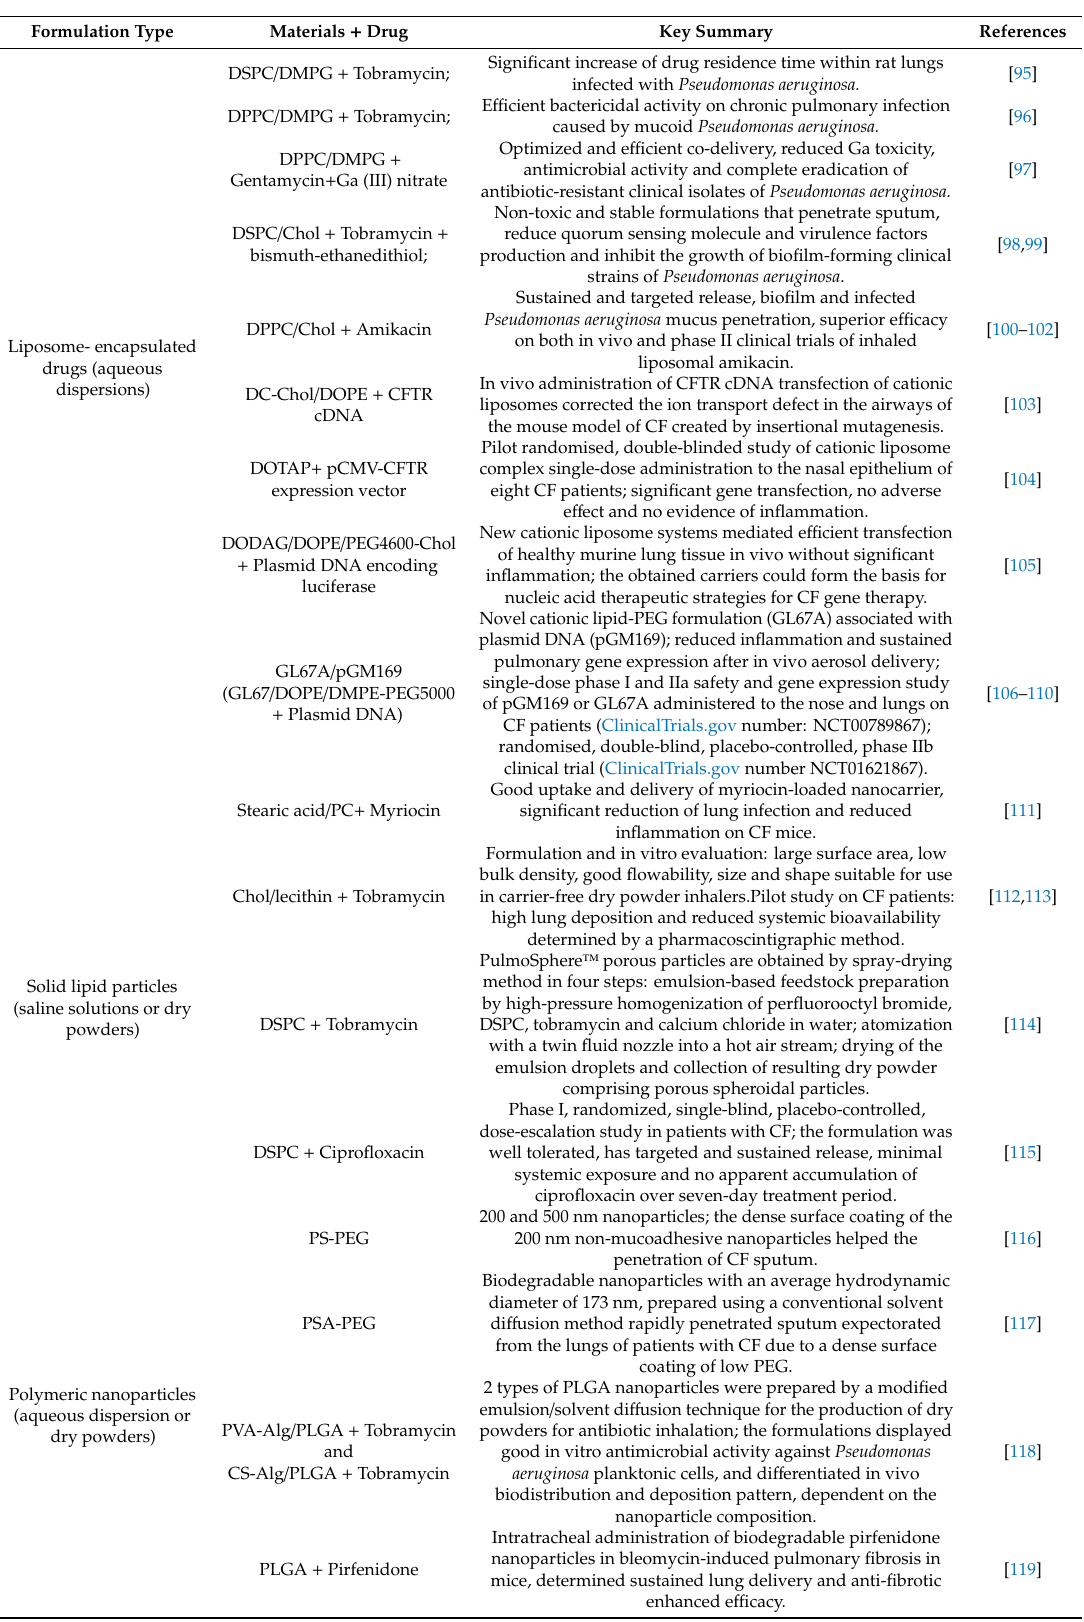
Table 6. Nanomaterials under development for CF